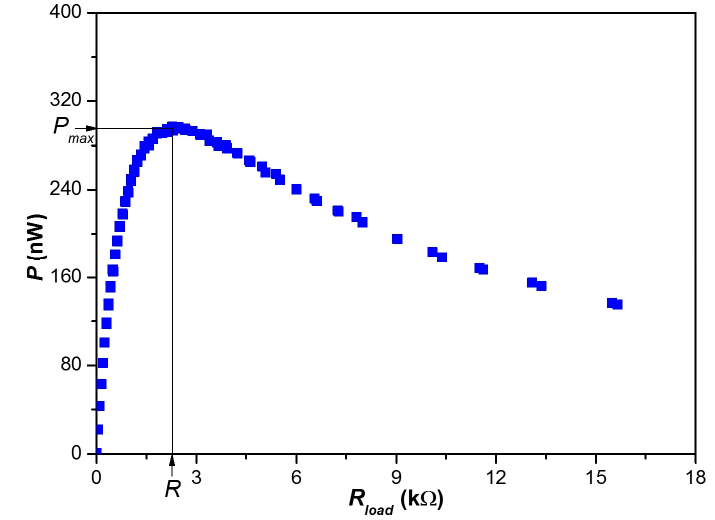
Figure 7. Typical power generation–electrical load curve of the anisotropic nanoporous anodic aluminum oxide membrane ( D a = 2 nm, L a = 2 μ m, c H = 0.5 M, c L = 0.01 M). aluminum oxide membrane ( D a